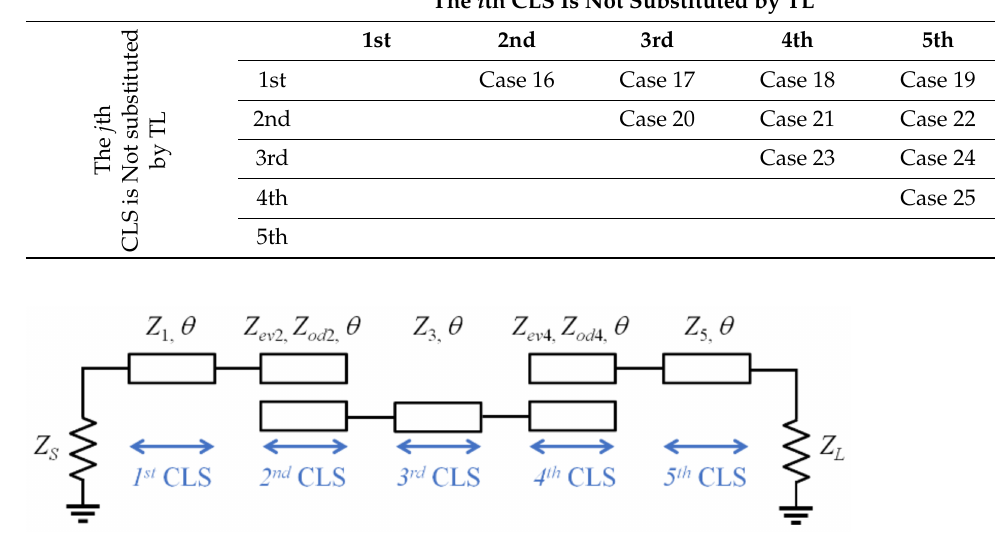
Table 4. The substitutable cases of category III.